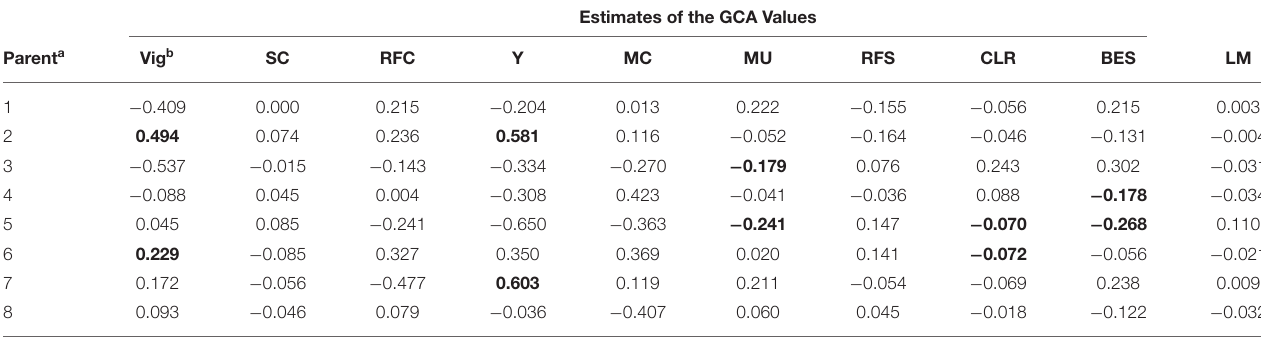
TABLE 7 | Estimated values for the general combining ability (GCA) effects of eight arabica coffee parents, based on the means of t10 agronomic traits. Estimates of the GCA Values